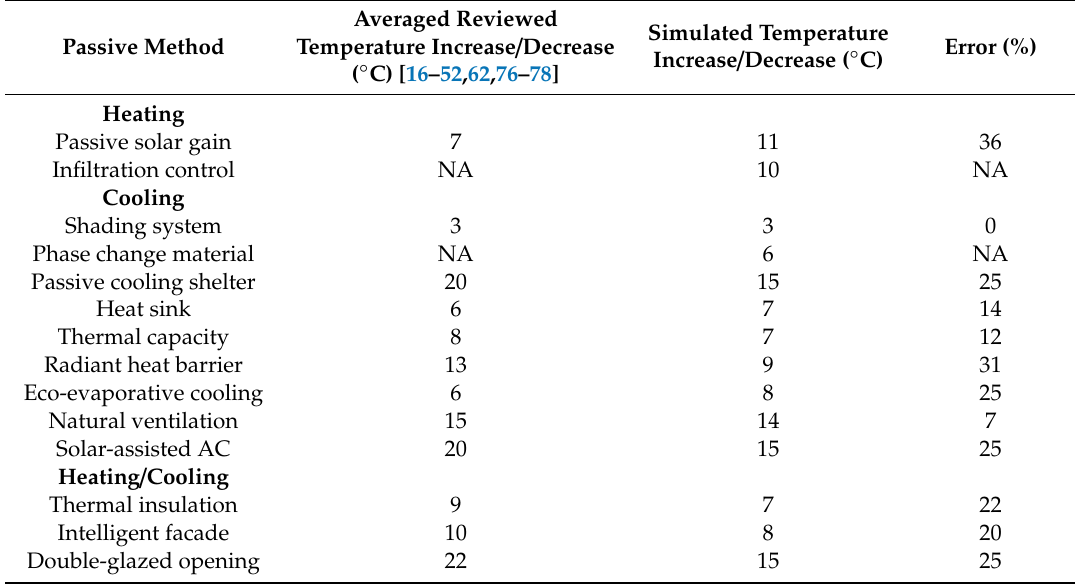
Table 7. Comparison of the thermal performance of the passive methods.